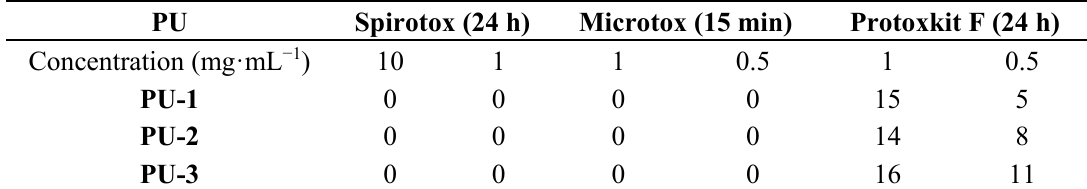
Table 3. Cytotoxicity of the obtained polyurethanes.